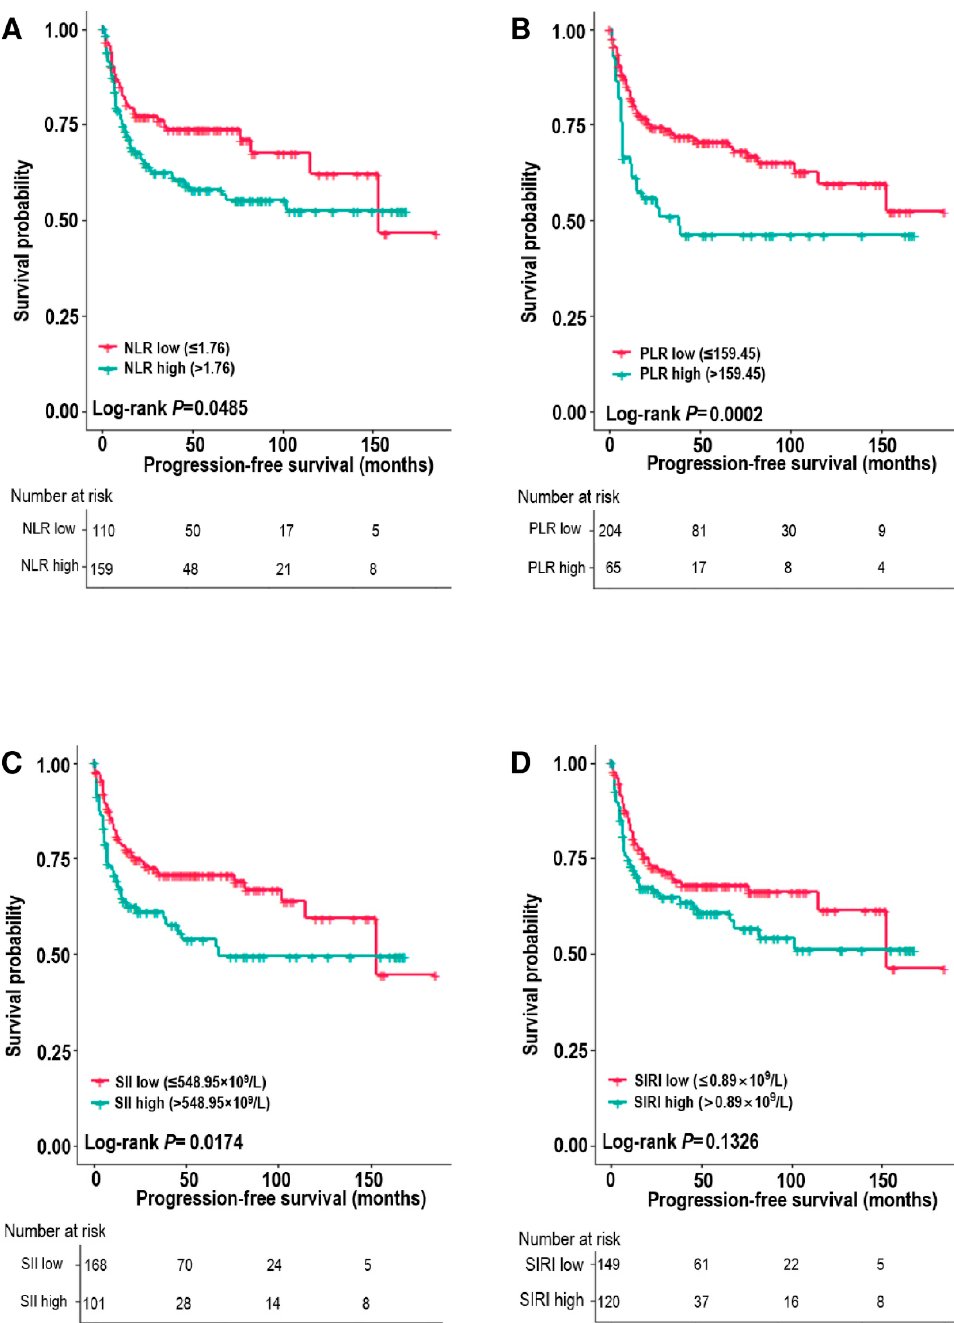
Figure 2. Progression-free survival estimates (Kaplan–Meier) according to the neutrophil–lympho- cyte ratio (NLR) ( A ), platelet–lymphocyte ratio (PLR) ( B ), systemic inflammation index (SII) ( C ), and systemic inflammation response index (SIRI) ( D ).